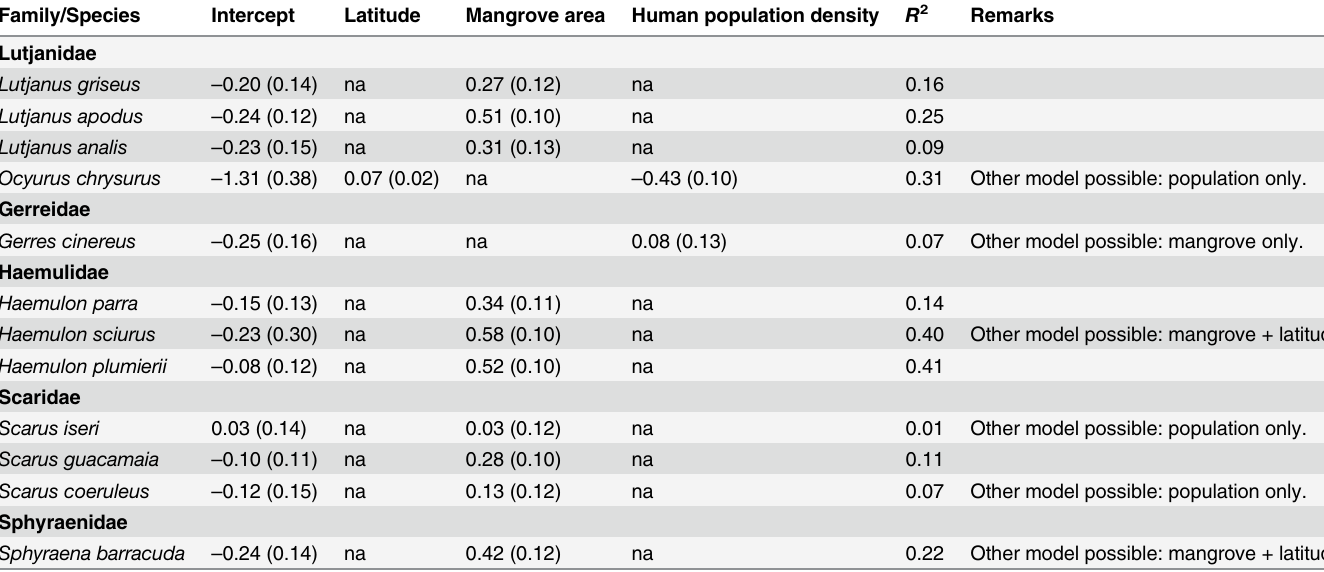
Table 2. Linear mixed effects model results (coefficients with one standard error) for reef fish abundances relative to mangrove coverage, human population density, and latitude. Shown are final models of best fit as determined by Akaike Information Criterion (AIC). “ Mangrove area ” is hectares of mangrove cover (rank transformed) and “ Human population density ” is people per square kilometer (rank transformed). See S2 Table for initial models. Table results presented here are from the model with the highest AIC weight. See “ Remarks ” for notes about evidence for other competing models. See S3 Table for more information on those models. R 2 are adjusted R 2 . na = variable was not in best approximating model.